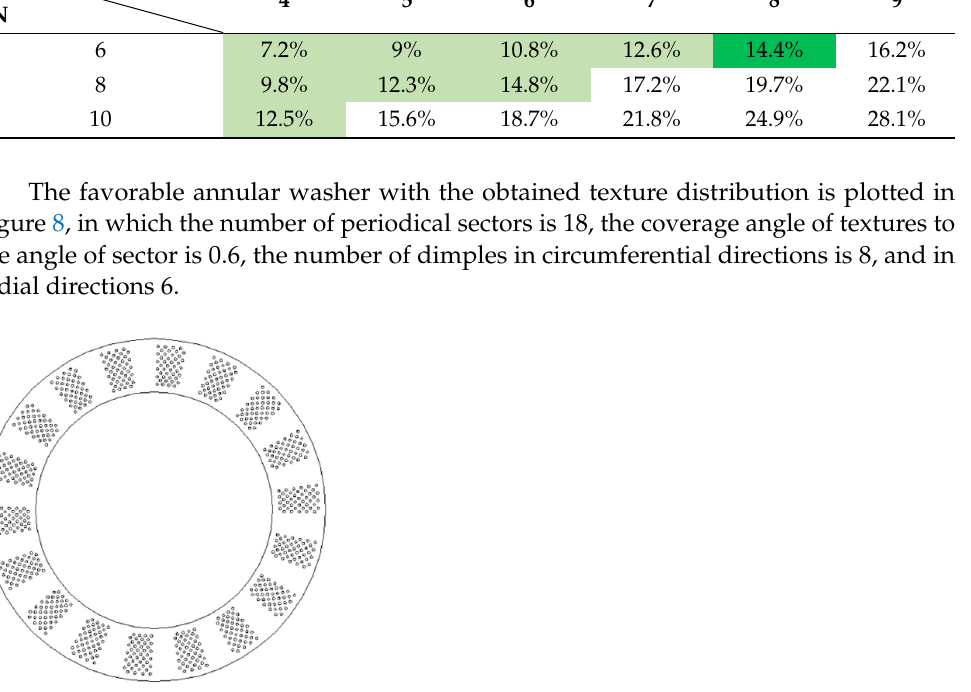
Figure 8. Distribution of texture with distributional parameters: N t = 18; K = 0.6; N = 6; M = 8.